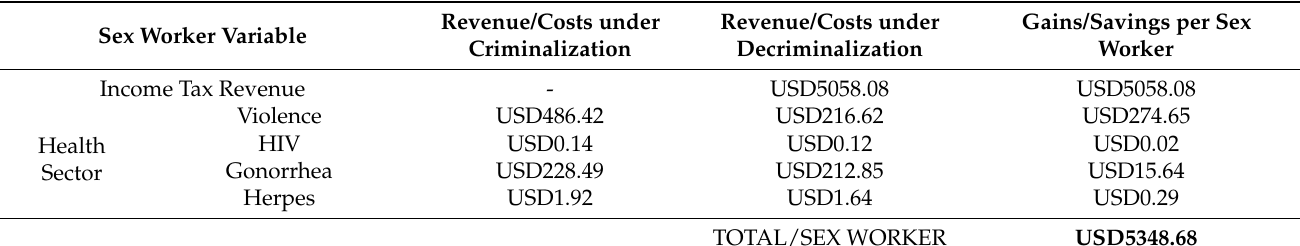
Table 12. Total annual economic gains per one sex worker following the decriminalization of sex work in DC (monetary values in 2020 USD).